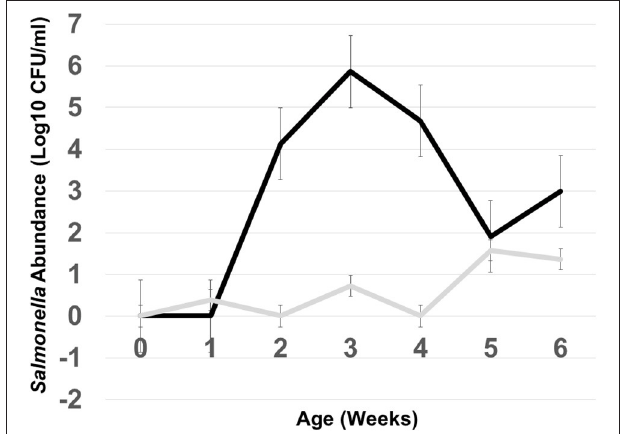
FIGURE 1 | Abundance of Salmonella in the poultry environment following oral administration of S. Typhimurium 934NR (black line) or 3147NR (gray line) to 1 day old chicks. Poultry litter was collected at placement of day of hatch chicks (time 0) and weekly, for 6 weeks. Salmonella abundance was determined from colony counts obtained from 10-fold serial dilutions and plating on MacConkey agar with nalidixic acid and rifampicin.